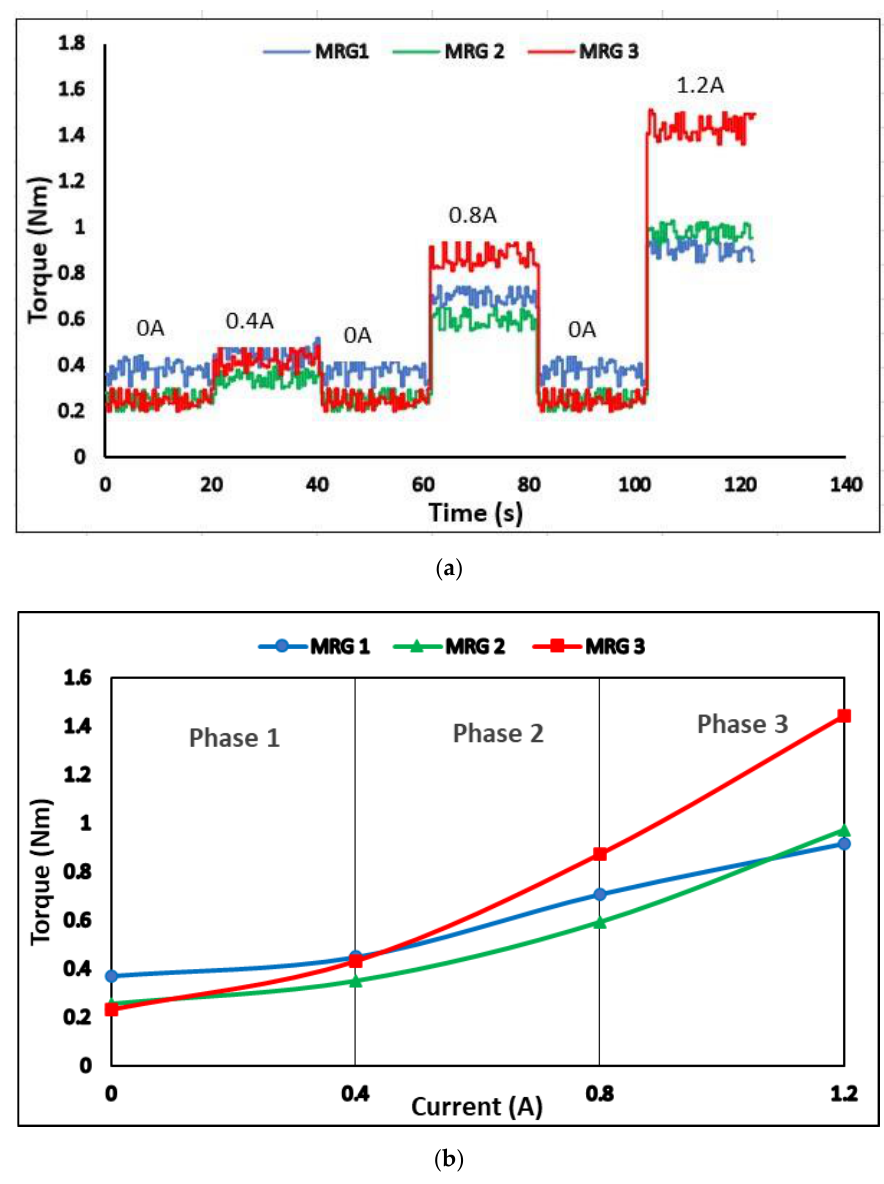
Figure 9. ( a ) Step response in relation to a 40 rpm and various current and ( b ) their average of torque under various of current.